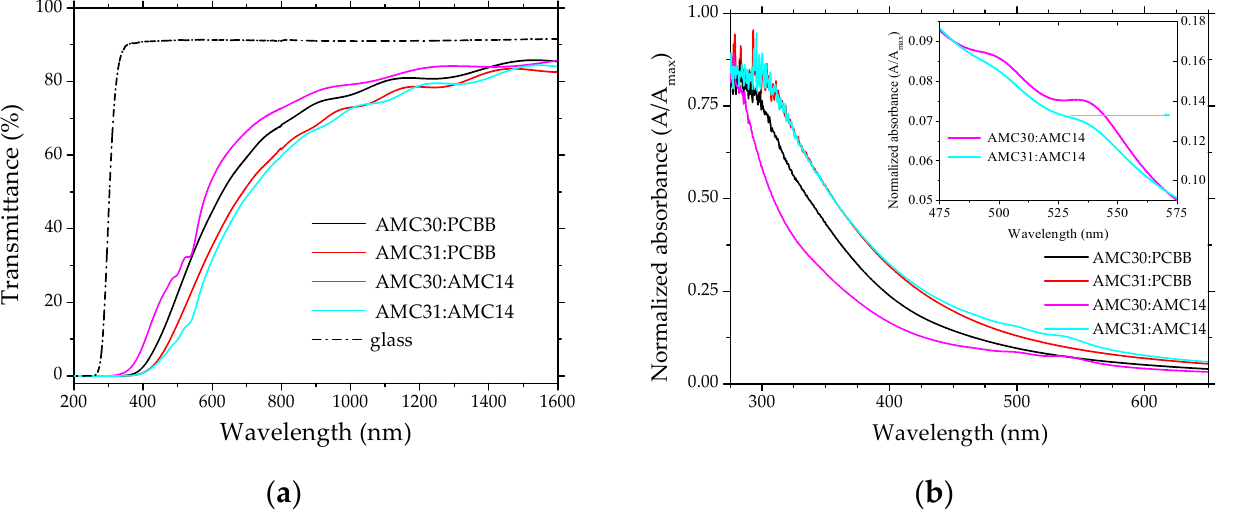
Figure 4. UV-Vis transmission spectra of the AMC30/AMC31:PCBB/AMC14 mixed layers on glass ( a ); normalized absorbance spectra of these mixed layers deposited on glass ( b ). Inset shows the normalized absorbance of the mixed layers in the range 475–575 nm. A = Absorbance; A max = maximum absorbance.